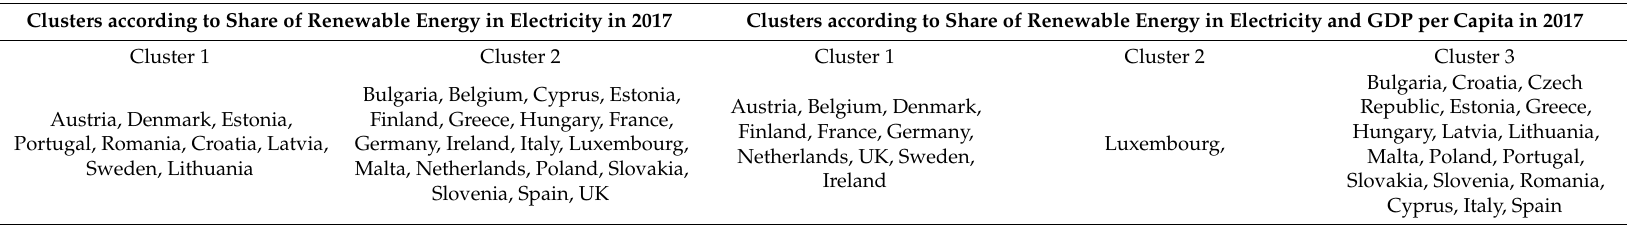
Table 4. Clusters of countries according to the share of renewable energy in the final consumption in the EU-28 in 2017 (k-means method). Clusters according to Share of Renewable Energy in Electricity in 2017 Clusters according to Share of Renewable Energy in Electricity and GDP per Capita in